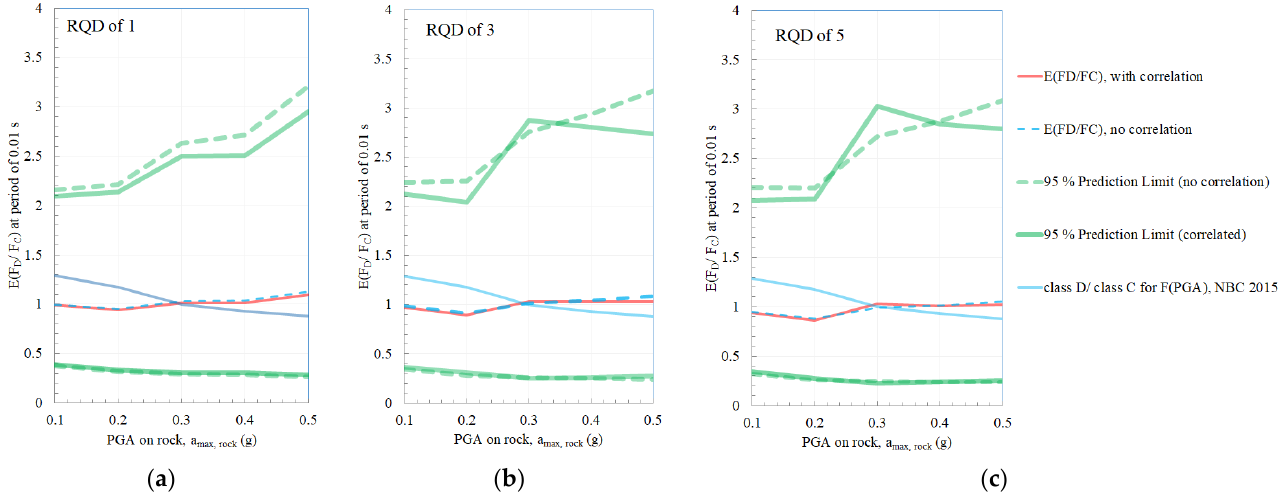
Figure 18. Comparison between (F D /F C ) at T = 0.01 s and the site factors in NBCC (2015) for RQD of 1 ( a ), 3 ( b ) and 5 ( c ).